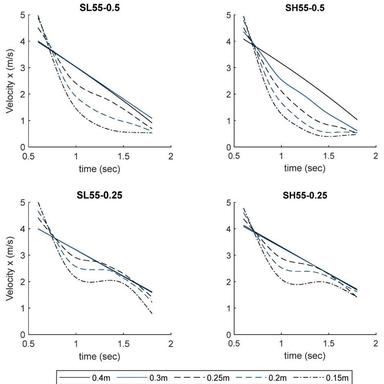
Average flow velocity measured at different sections upstream of the obstacle for 55◦ flume angle.